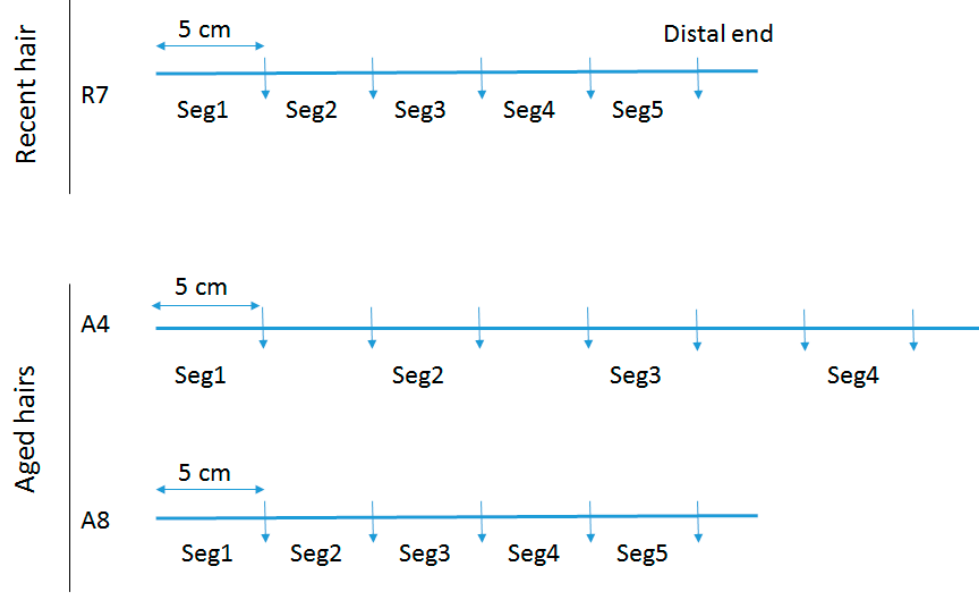
Figure 1. Segmentation of hairs. Hairs R7, A4, and A8 were long hairs cut in segments used to assess total DNA quantity and quality along the length of individual hair shafts.